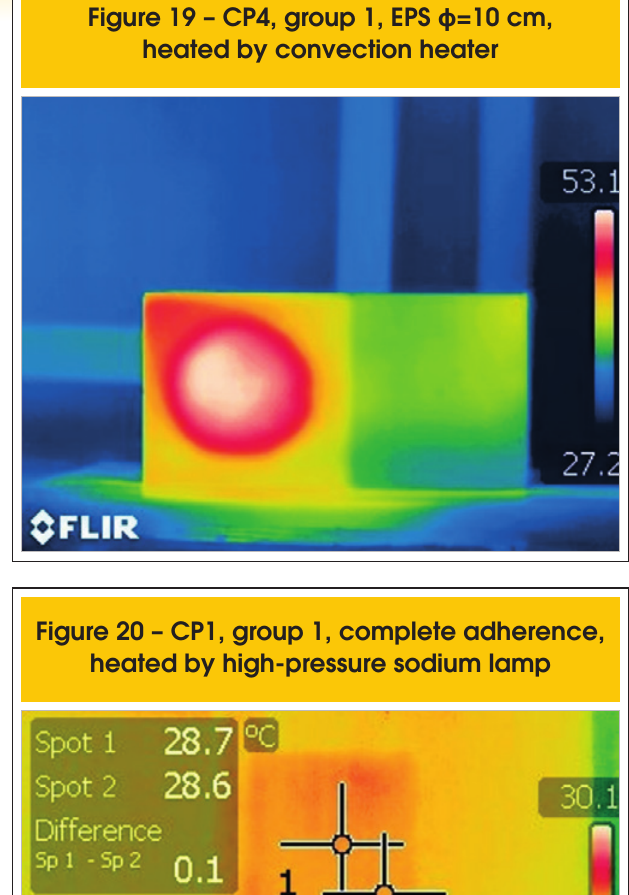
Figure 19 – CP4, group 1, EPS ϕ =10 cm, heated by convection heater